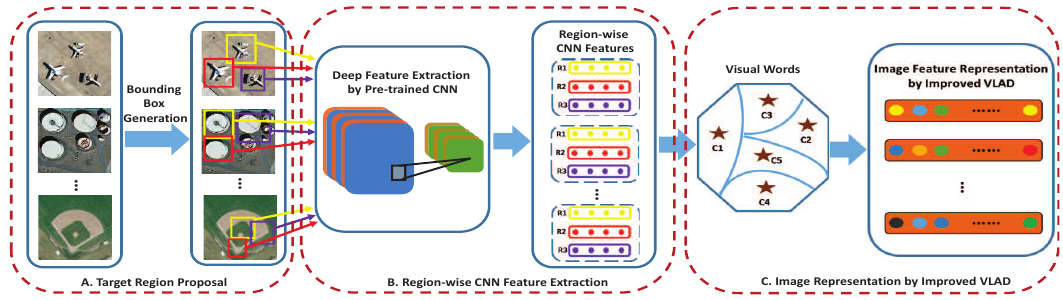
Figure 2. The framework of the proposed region-wise deep CNN feature learning